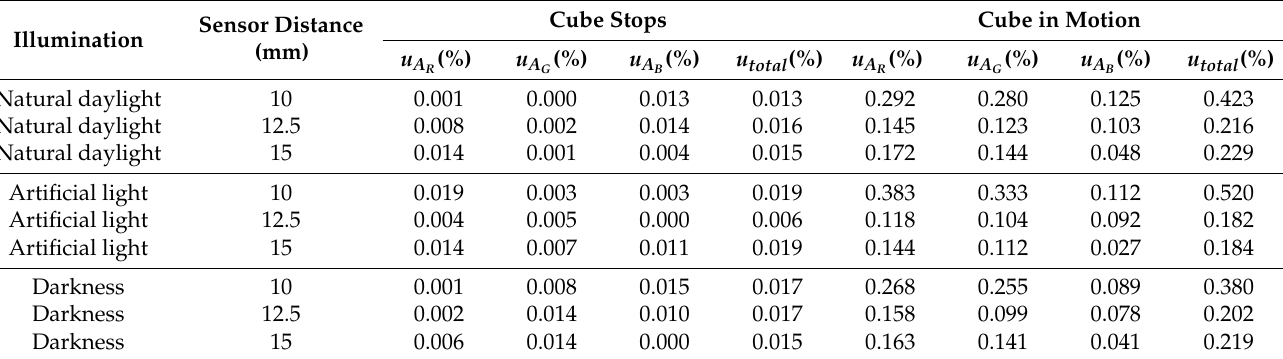
Table 8. Type A standard uncertainty for a yellow